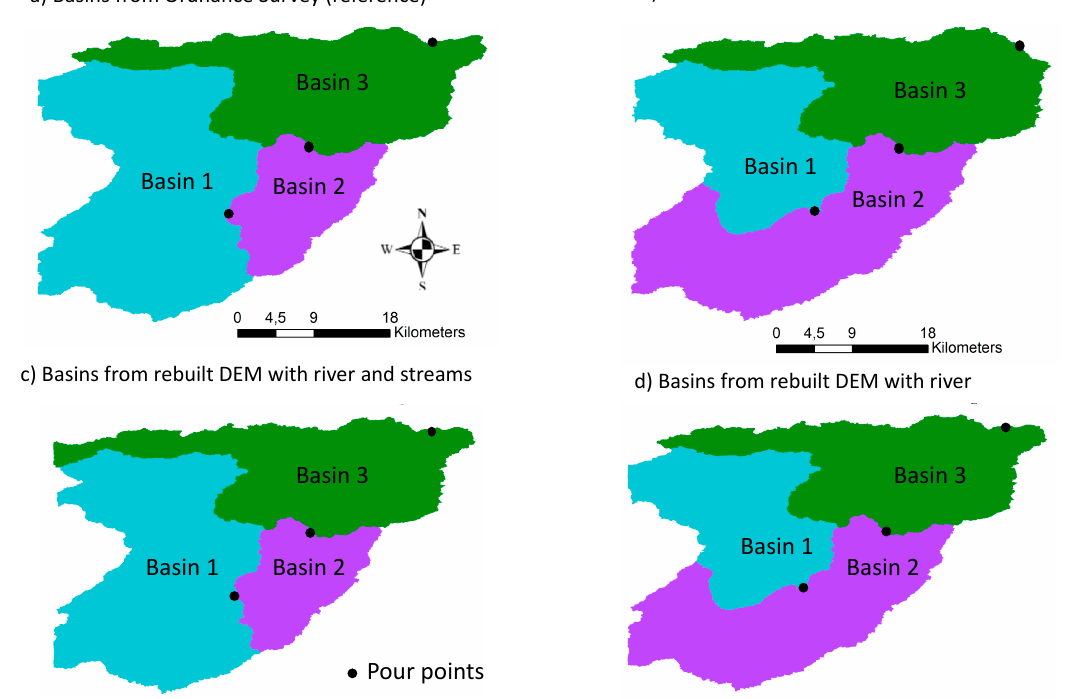
Figure 25. Basins generated for the indicated pour points from: ( a ) the reference DEM, ( b ) the original SRTM 30, ( c ) the rebuilt DEM with OSM rivers and streams, and ( d ) the rebuilt DEM with OSM rivers.